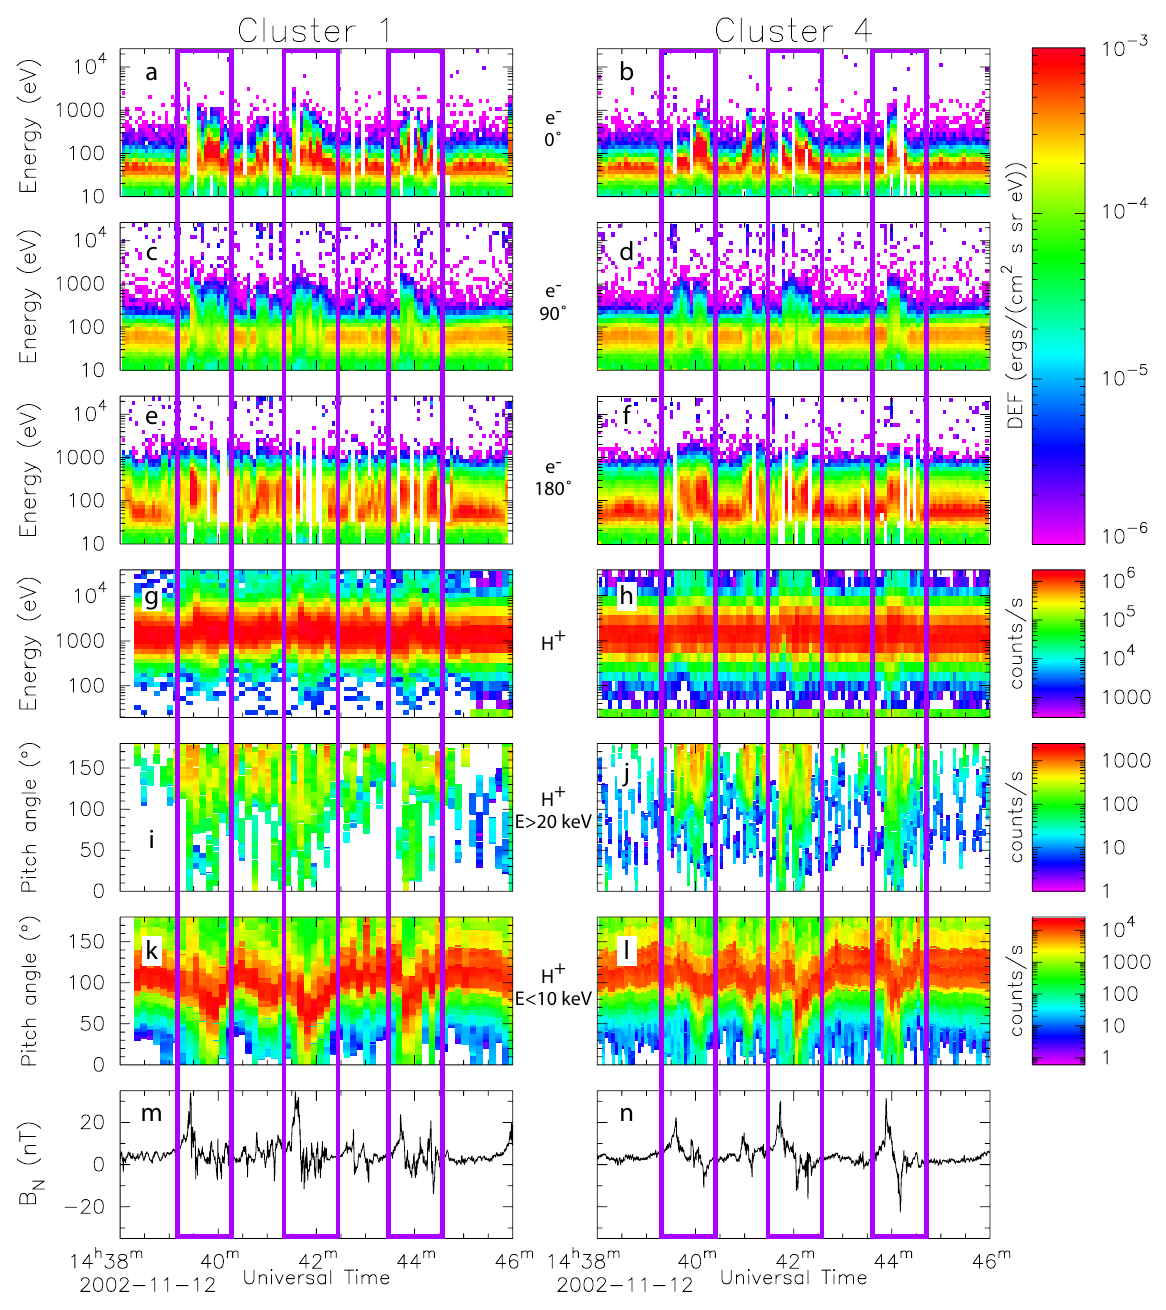
Fig. 14. Plasma and magnetic field data from three FTEs observed on the 12 November 2002. Data from Cluster 1 (left) and Cluster 4 (right) are shown. The panels represent the electron distribution observed by PEACE parallel, perpendicular and antiparallel to the magnetic field (panels a–f ), the omnidirectional proton count rate observed by CODIF (panels g and h ), the proton pitch angle distribution observed for ions at high energies (30keV > E > 20keV, panels i and j ) and at low energies (10keV > E > 100eV, panels k and l ), and the B N component (panels m and n